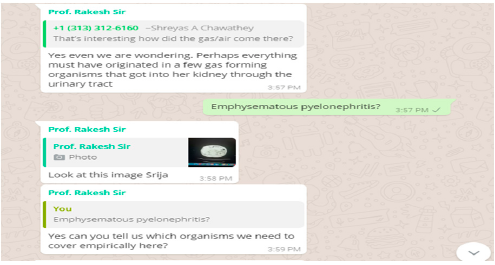
Figure 4. Illustrating the patient data shared online into our CBBLE online network.